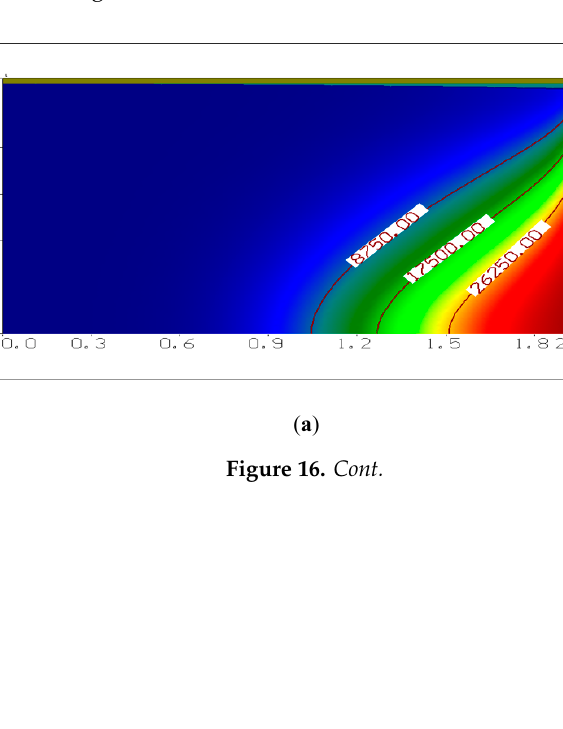
Figure 15. Relationship between intrusion length (X T ) and recharge for different slopes.